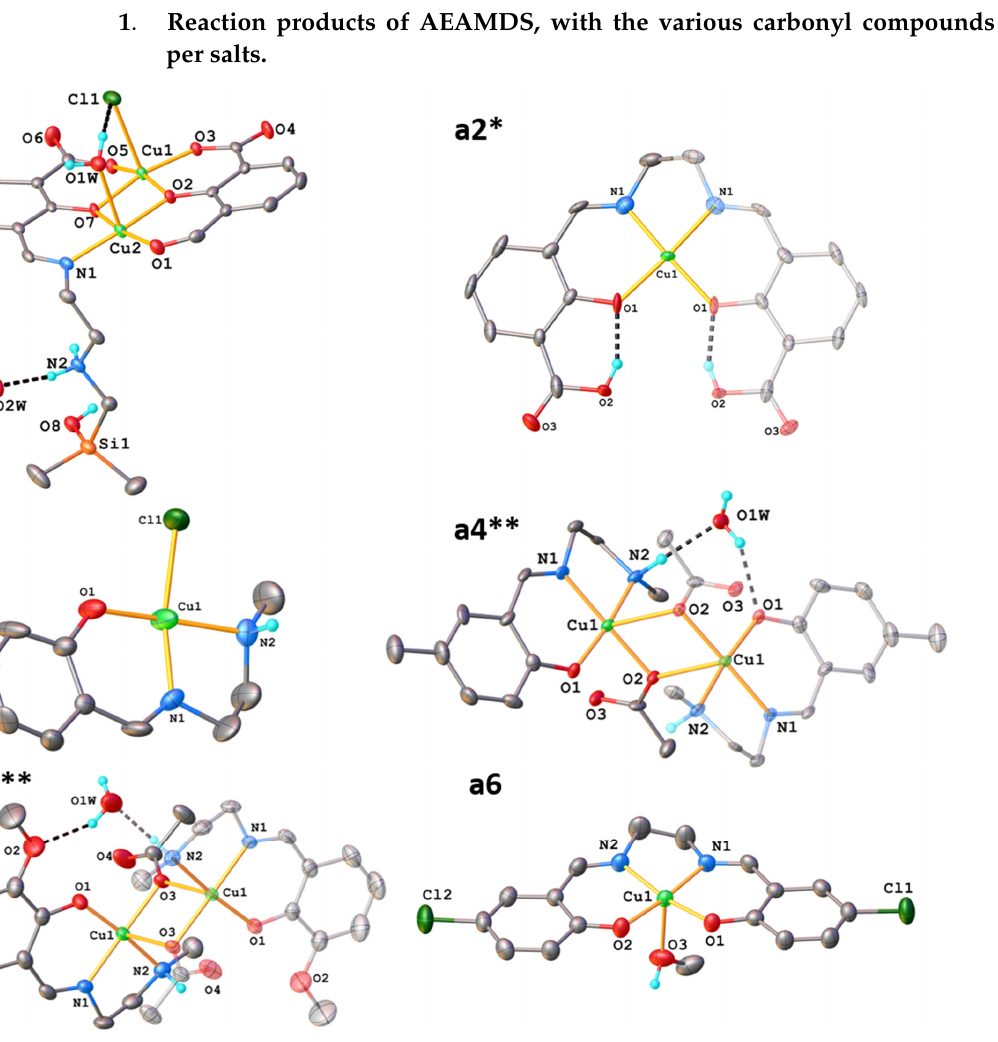
Figure 1. SC XRD analysis for compounds a1 – a6 (symmetry code: *—1 − x , + y , ½ − z, **—1 − x , 2 − y , 1 − z ; ***—1 − x , 1 − y , 1 − z ). CCDC— a1 : 2064429; a2: 818612.